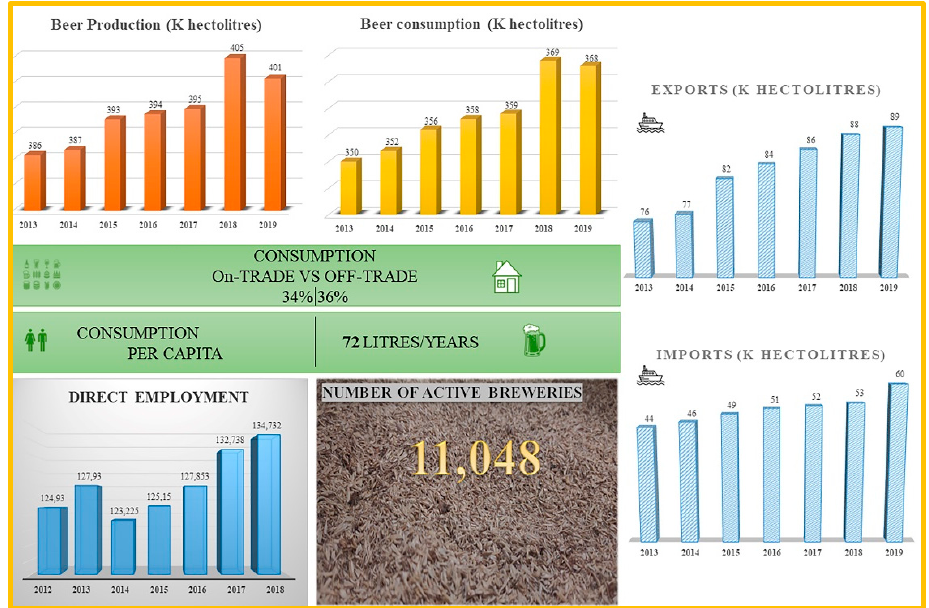
Figure 6. Economic data of EU beer production, consumption, import/export, and direct employment for year 2019.